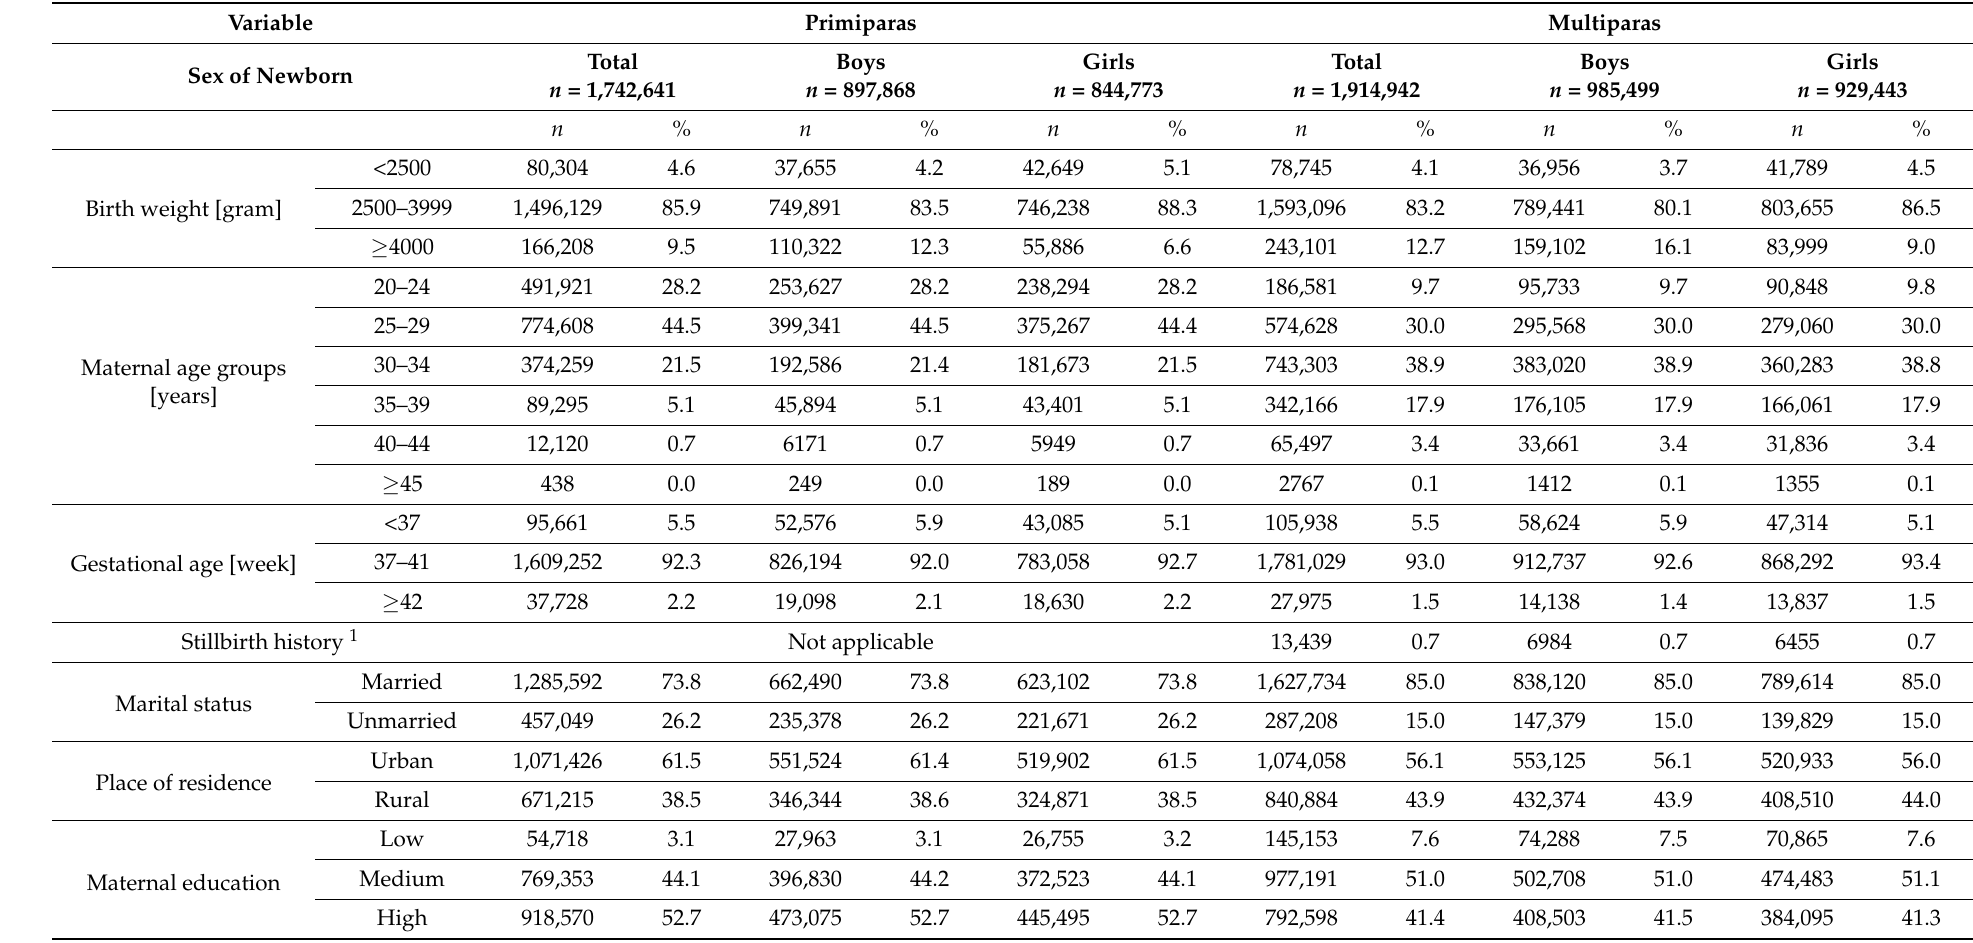
Table 1. Maternal and newborn characteristics analyzed in the study for the period between 2008 and